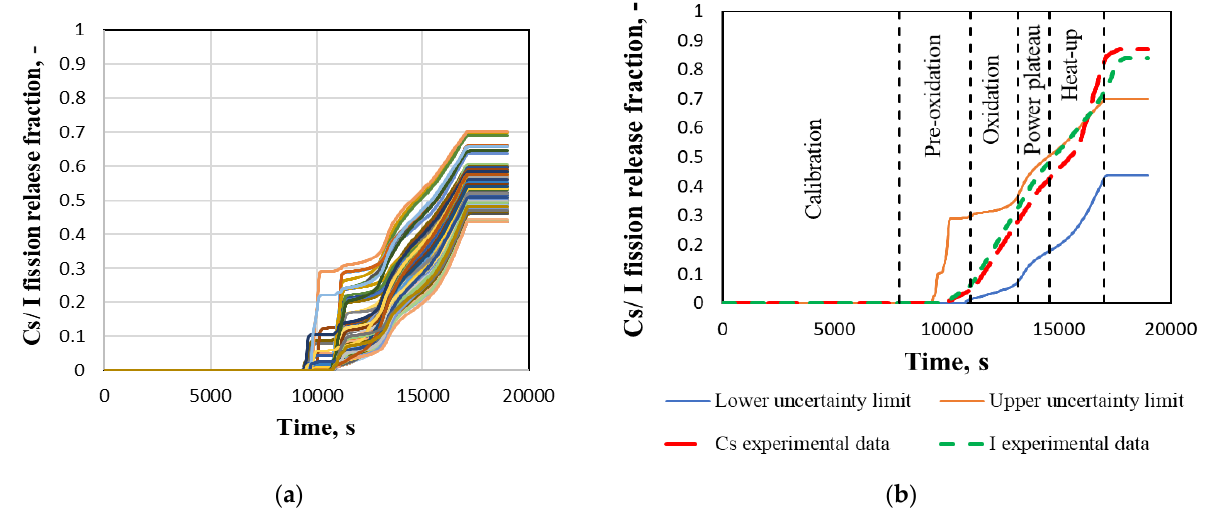
Figure 11. Cs and I release fraction: ( a ) 100 calculation results; ( b ) upper and lower uncertainty limits compared with experimental data.